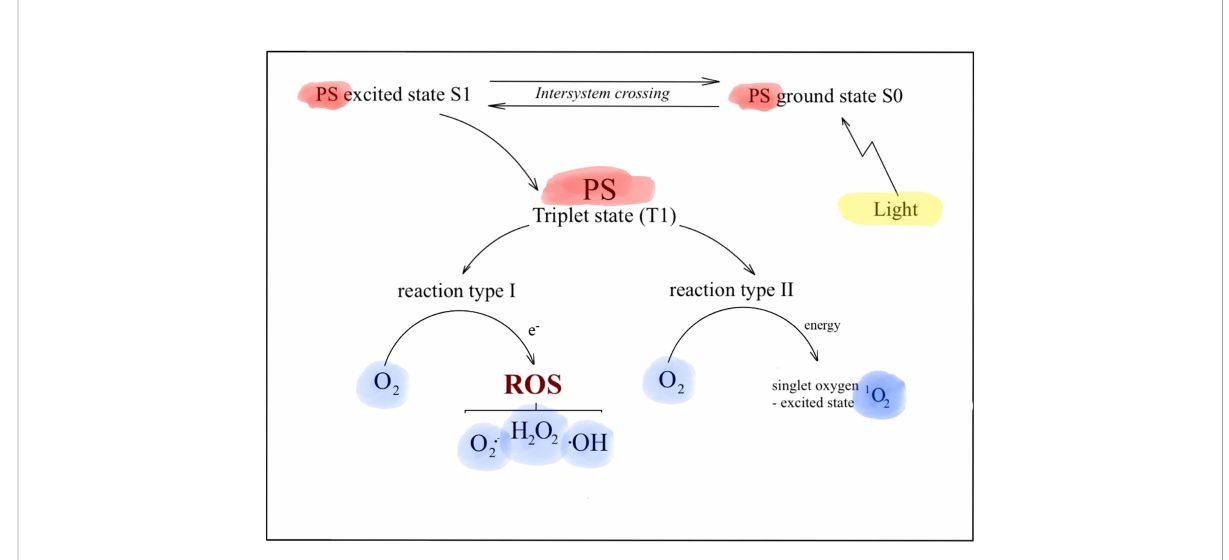
FIGURE 2 The mechanism of photodynamic therapy